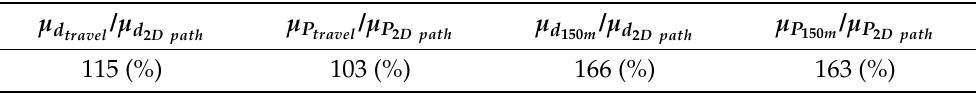
Table 8. Normalized travel distance comparison between airspace geofencing and 150 m flight corridor